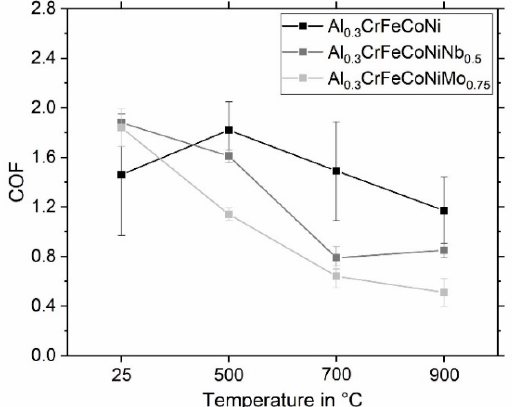
Figure 4. Coefficient of friction (COF) of the last 100 s of the high-temperature wear tests of HVOF- sprayed Al 0.3 CrFeCoNi, Al 0.3 CrFeCoNiNb 0.5 and Al 0.3 CrFeCoNiMo 0.75 . The COF decreases with